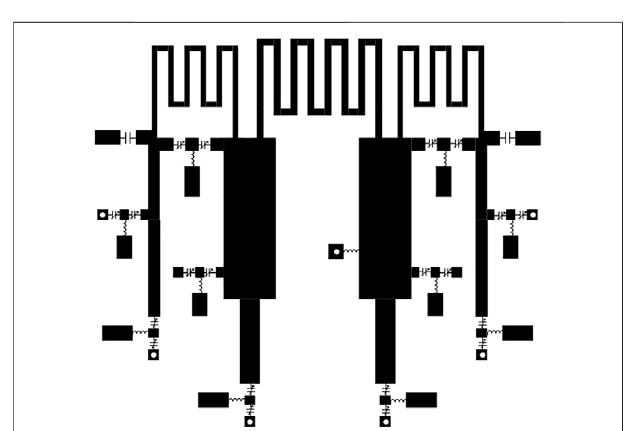
FIGURE 5 | The layout of the